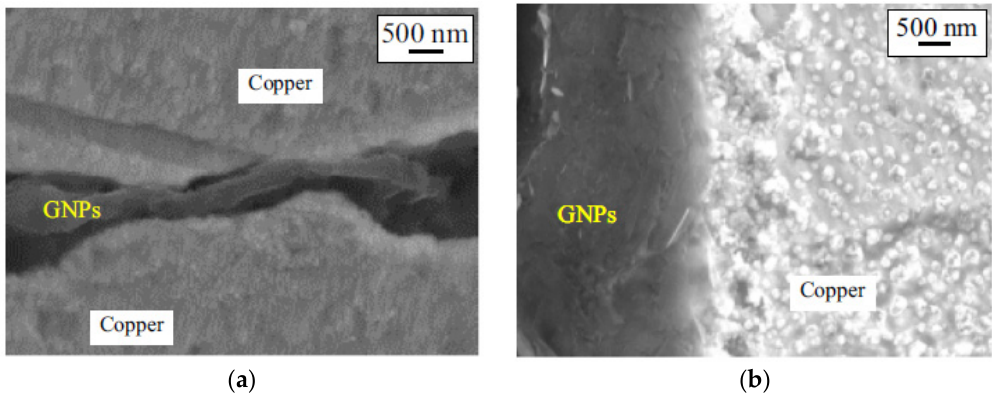
Figure 12. Field emission scanning electron microscopy (FESEM) images of the Cu/GNPs interfacial bonding for the: ( a ) as-sintered; ( b ) as-sintered followed by the HIPing process, reproduced from [8], with permission from Springer Nature, 2018.